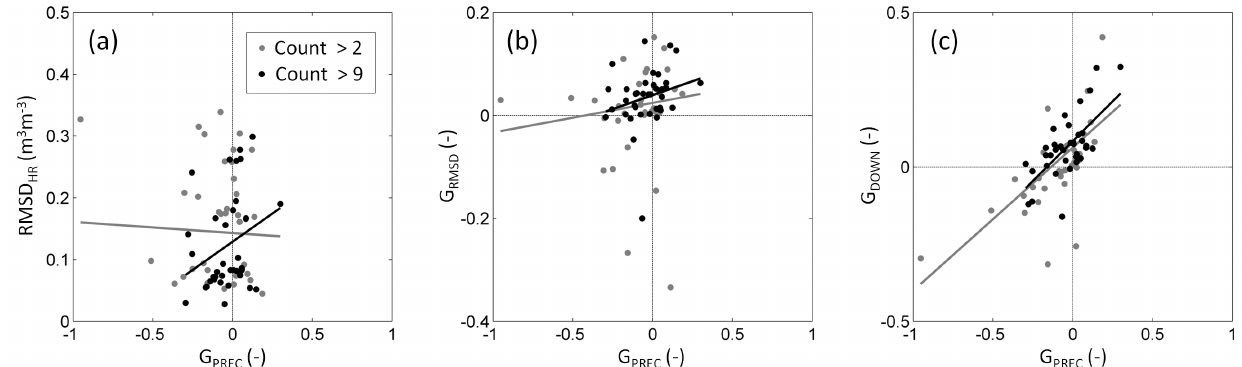
Figure 7. Performance metrics ( a – c ) vs. the disaggregation gain on time series correlation (G ) for datasets with a minimum sample count of three and 10 PREC